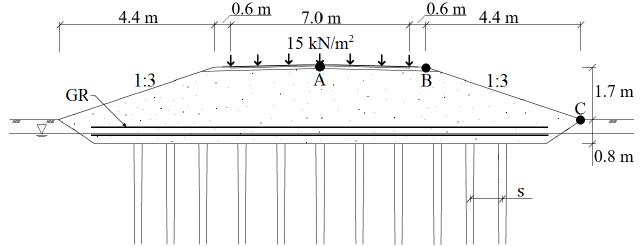
Figure 1. Cross section of the modelled road embankment. Displacement evaluated in points A, B and C. and